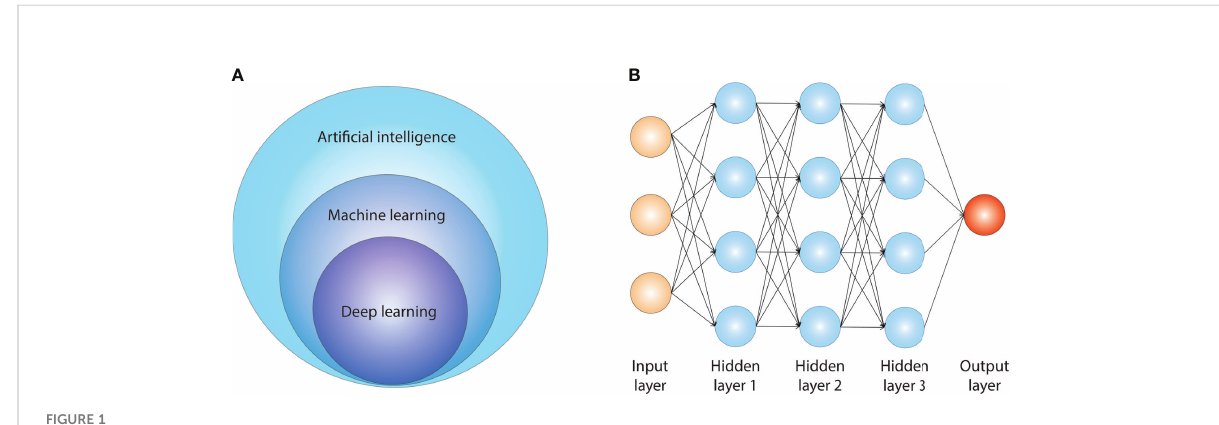
FIGURE 1 Arti fi cial intelligence and its sub- fi